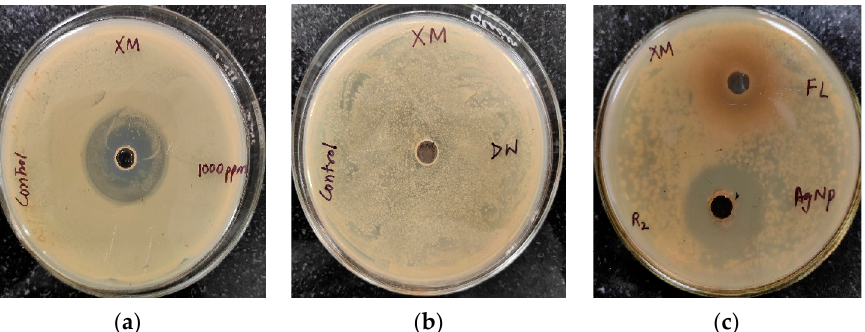
Figure 8. Antibacterial activity against Xanthomonas spp. (XM): ( a ) positive control (streptomycin); ( b ) negative control (distilled water (DW)); ( c ) Antibacterial activity against Xanthomonas spp. (XM) using leaf extract (FL) and AgNPs.